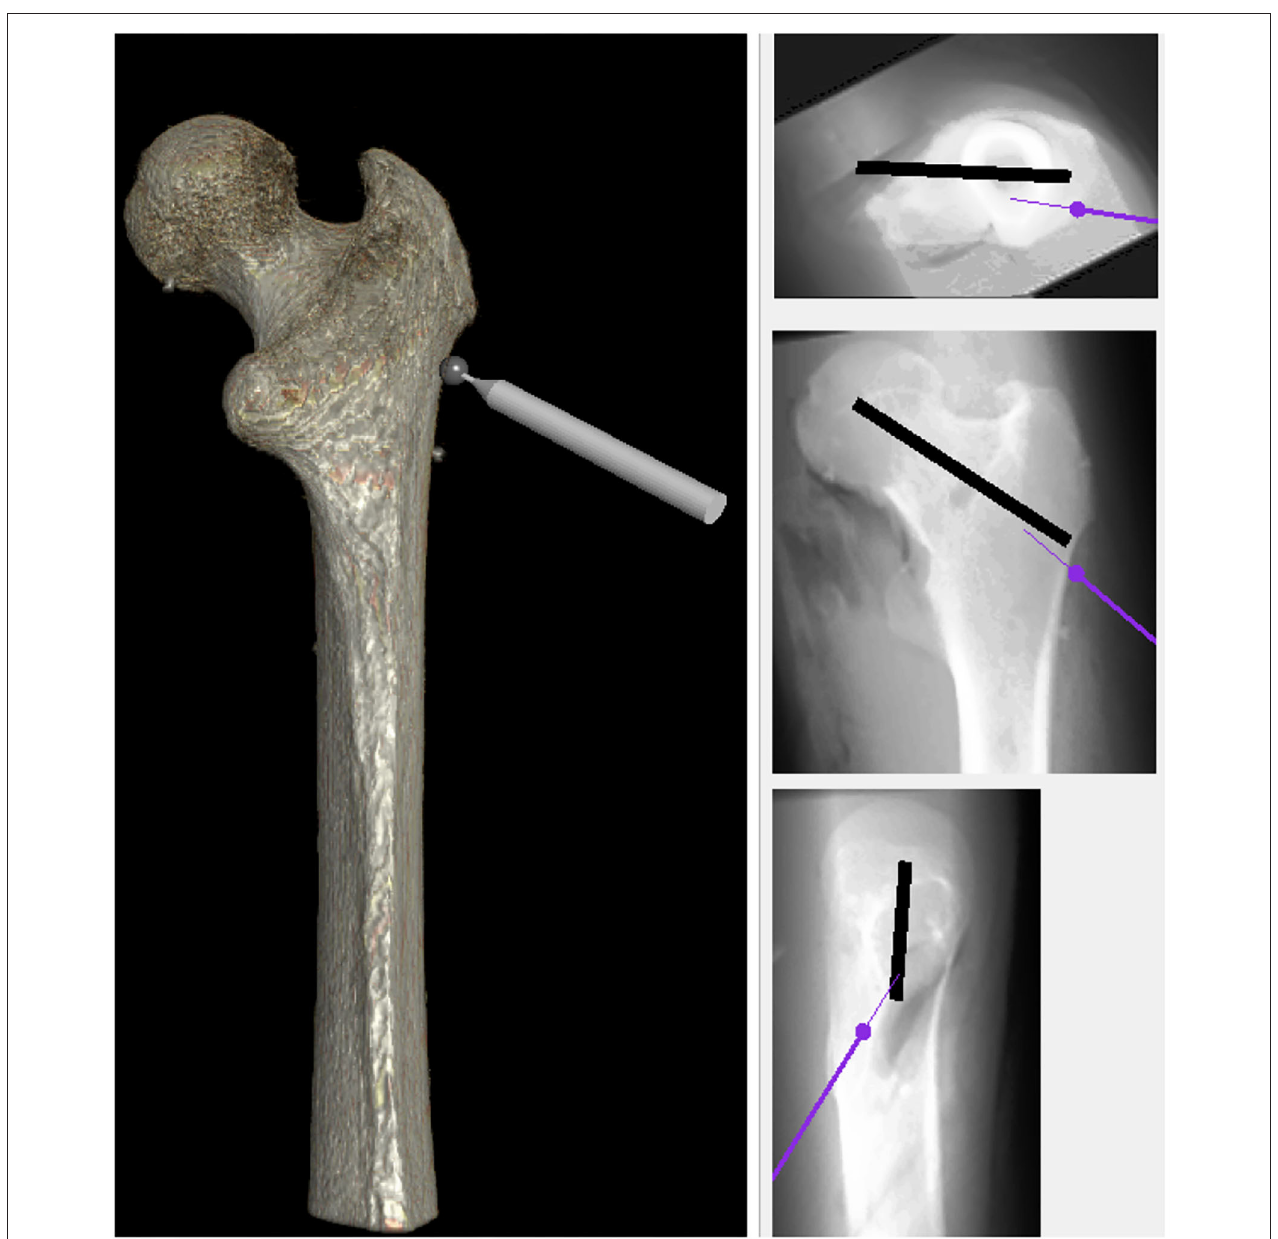
FIGURE 5 | The simulation was equipped with X-ray view for providing users an environment more analogous to the real operating room. Similar to the real operation room, it has three views: the top, front, and